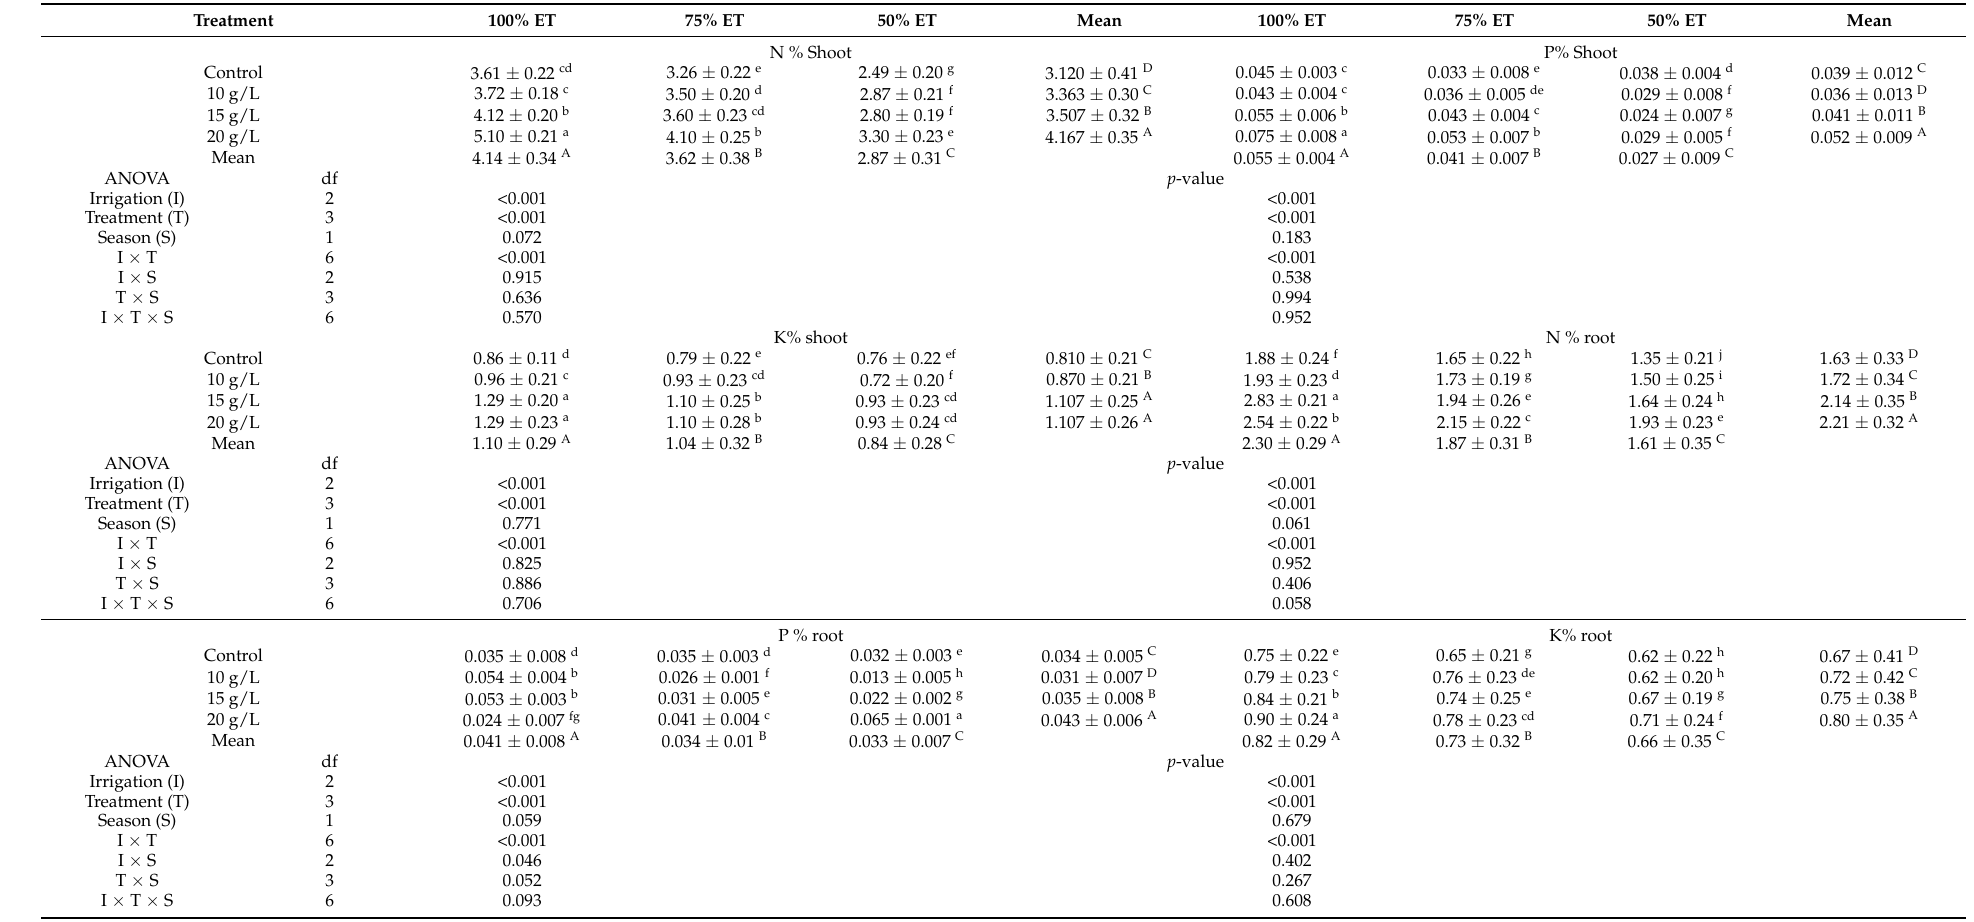
Table 2. Influence of potassium silicate at different concentrations on N%, P%, and K% of squash shoot and root under different irrigation regimes.